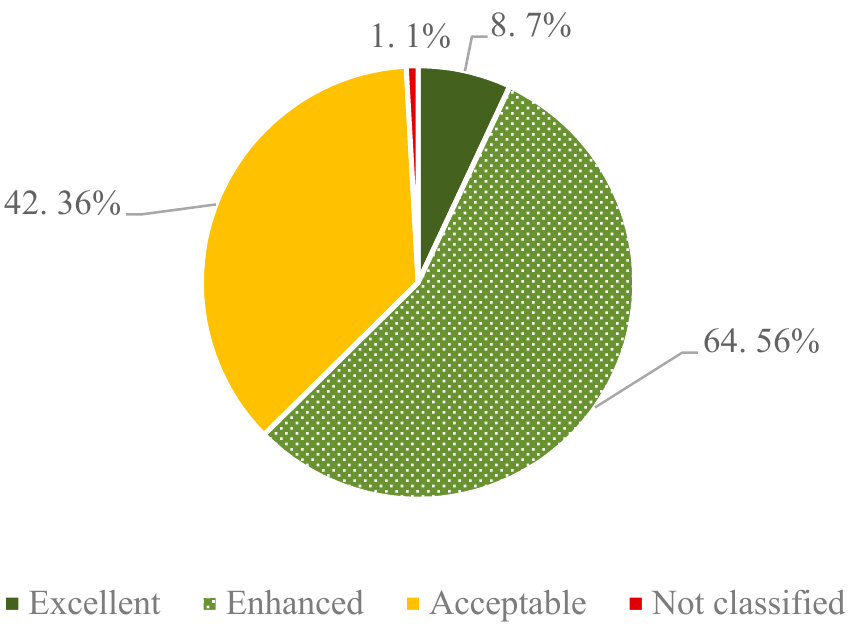
Figure 2. Results of the “overall welfare score”, according to the Welfare Quality ® assessment protocol, in the 115 project